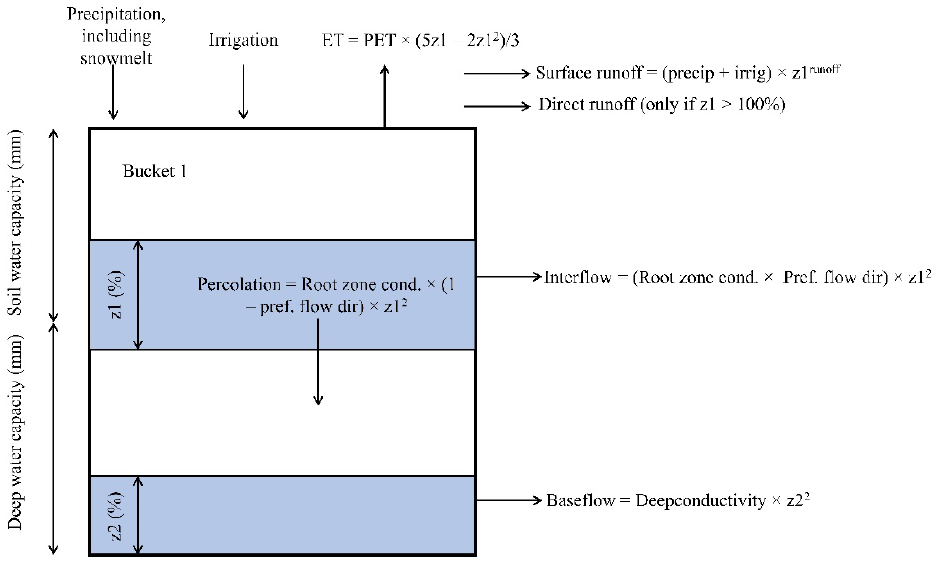
Figure 4. The conceptual diagram and equations used in the soil moisture method.